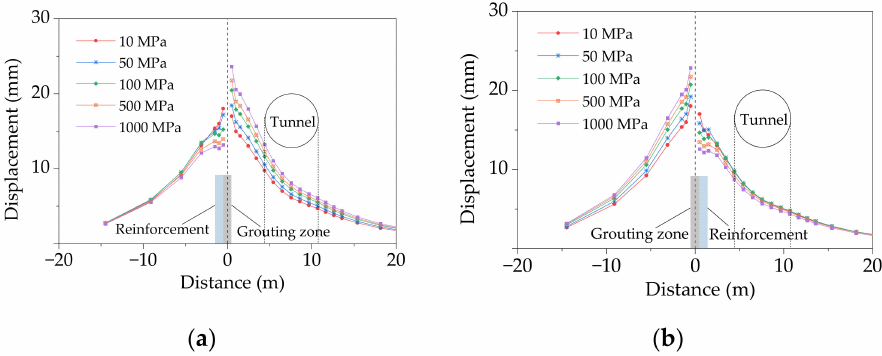
Figure 12. Soil displacement perpendicular to the grouting zone. ( a ) From far to near (Case 1); ( b ) from near to far (Case